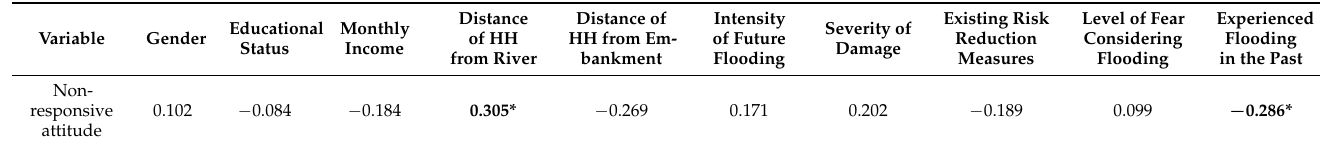
Table A3. Correlations between non-responsive attitude and socio-economic and risk-exposure